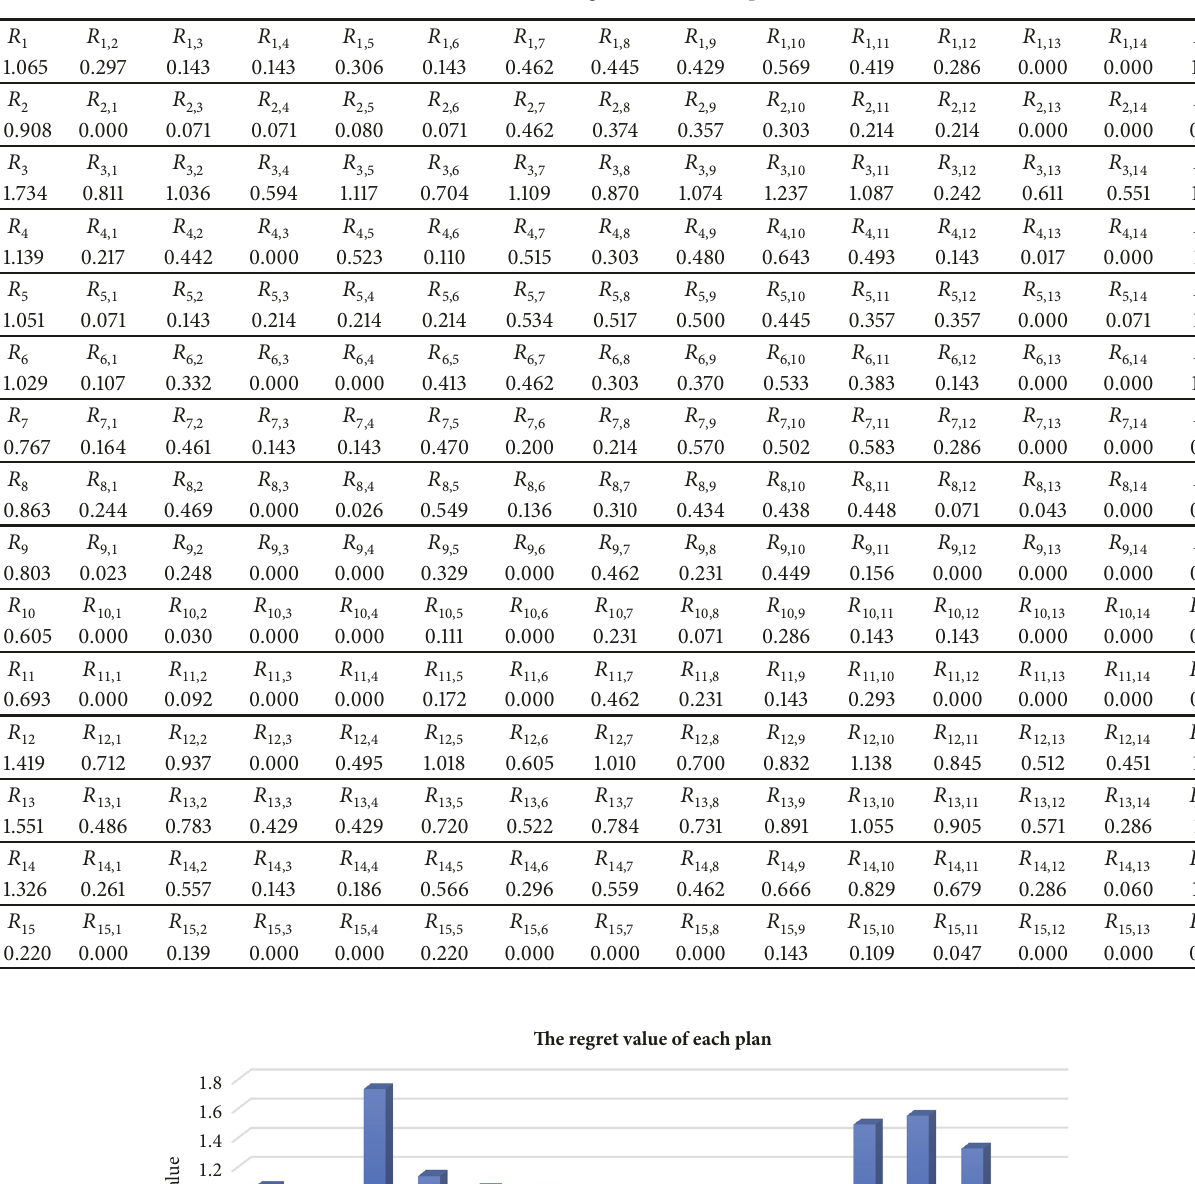
Table 7: The regret value of each plan.